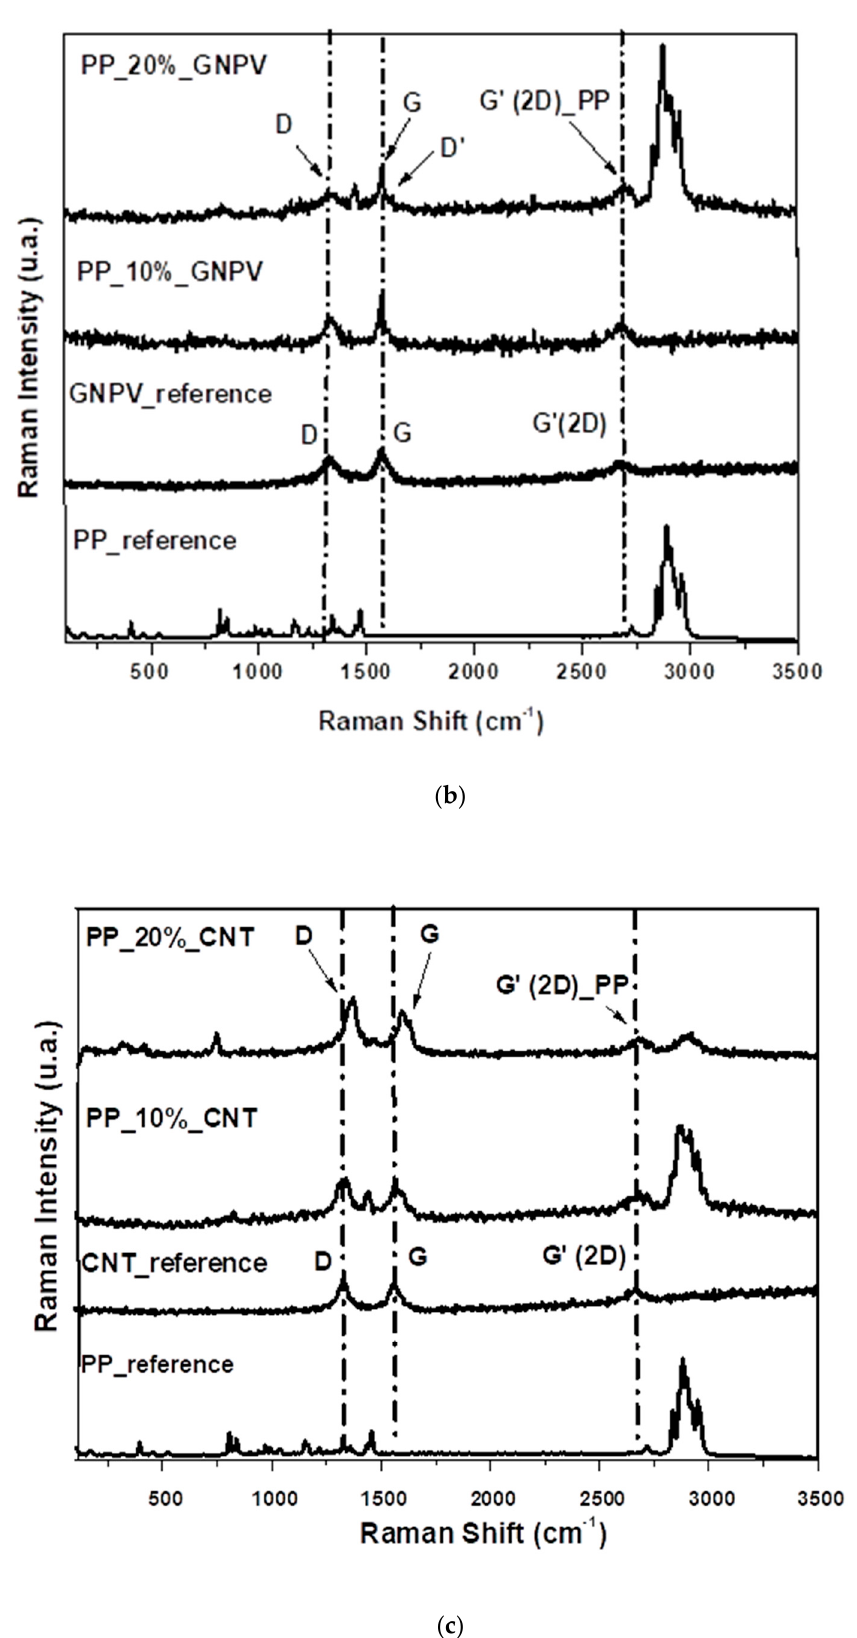
Figure 3. Raman spectra of GNPS ( a ), GNPV ( b ), and CNTs ( c ) fillers, matrix, and the nanomaterials ‐ PP ‐ based composites.